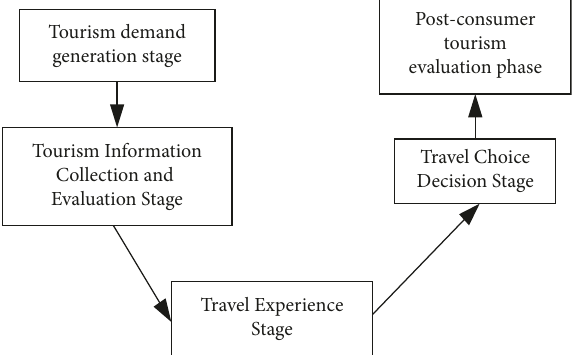
Figure 6: Schematic diagram of tourist consumer’s consumption behavior.